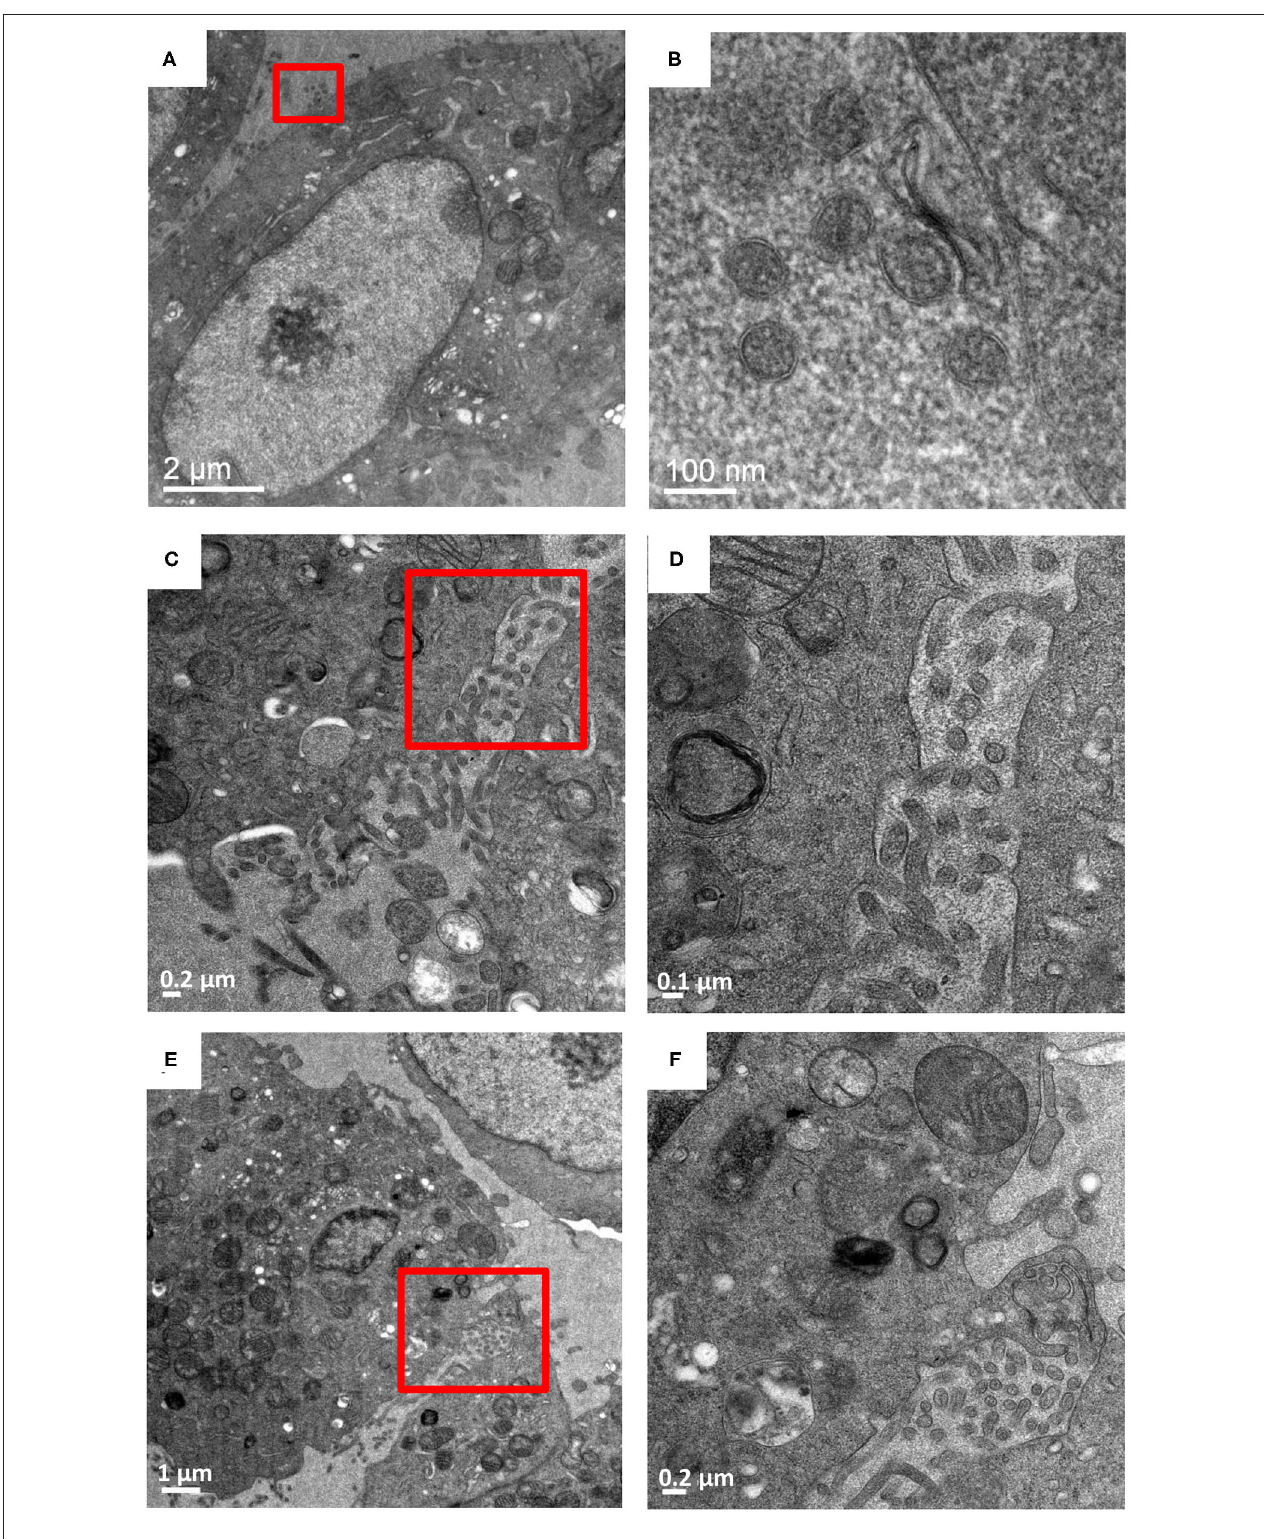
FIGURE 2 | Budded Hantaan virions between adjacent cells. Vero cells infected with HTNV imaged at 9 dpi. (A,C,E) are images at 5,000–6,000 X magnification with (B,D,F) as corresponding images of the regions show in in the red boxes at 13,500–26,000 X magnification. (A,B) Virions measuring 70–90nm exterior to the plasma membrane. (C,D) virions between two adjacent cells. (E,F) show virions between two adjacent cells sequestered by plasma membrane projections from the cells.